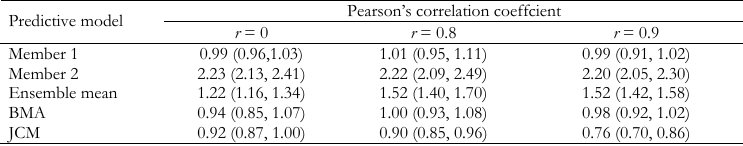
Pearson’s correlation coeffcient Predictive